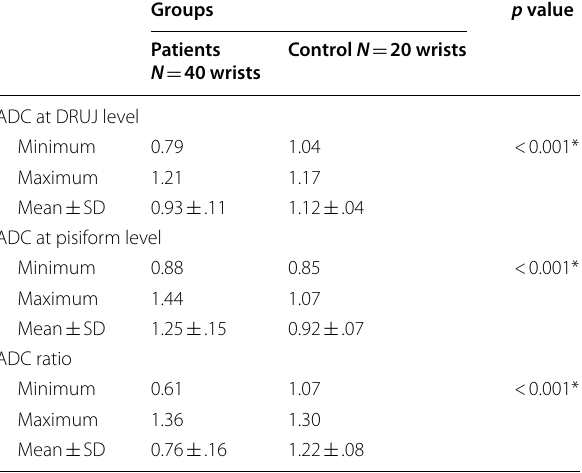
Table 2 Comparisons between the patients and control groups according to median nerve ADCs at the level of distal radio-ulnar joint and pisiform and ADC ratio